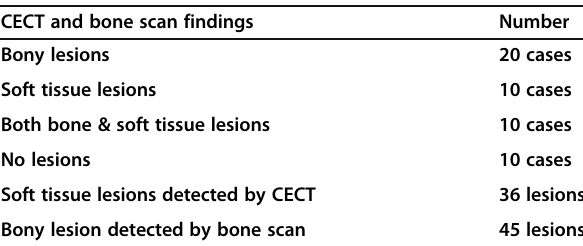
Table 3 Results of CT and bone scan in 50 patients as gold